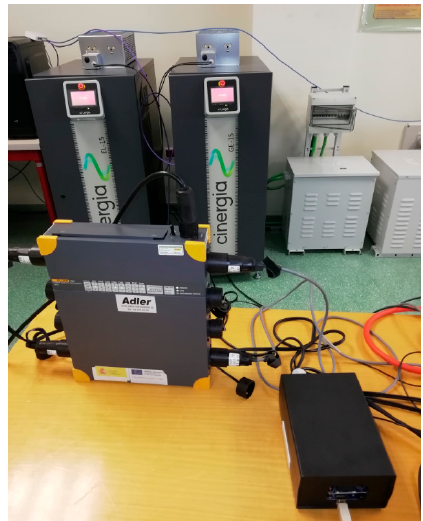
Figure 7. Test equipment and OSPPSM in the laboratory at Jaen university.